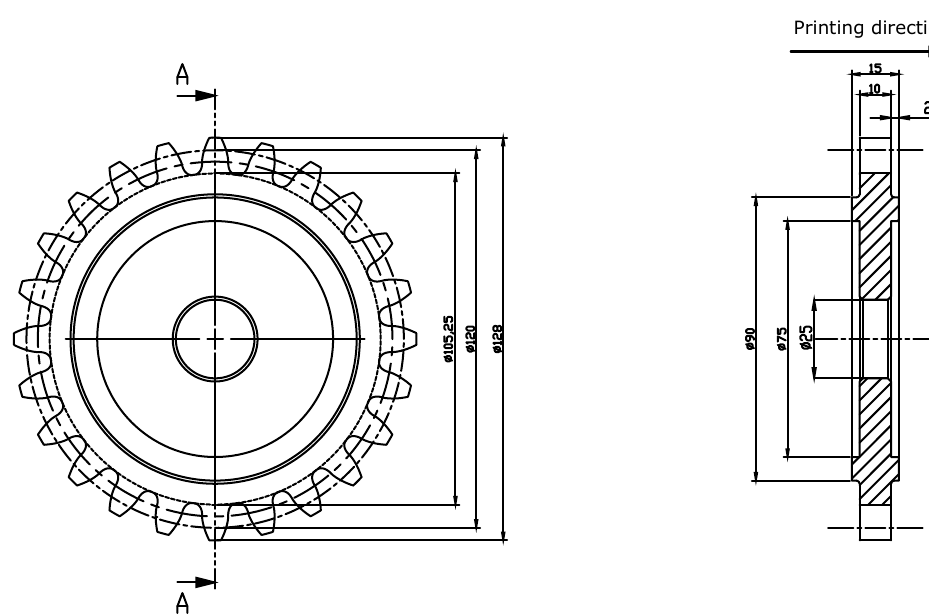
Figure 3. Schematic drawing of the tested gears; dimensions are in mm.